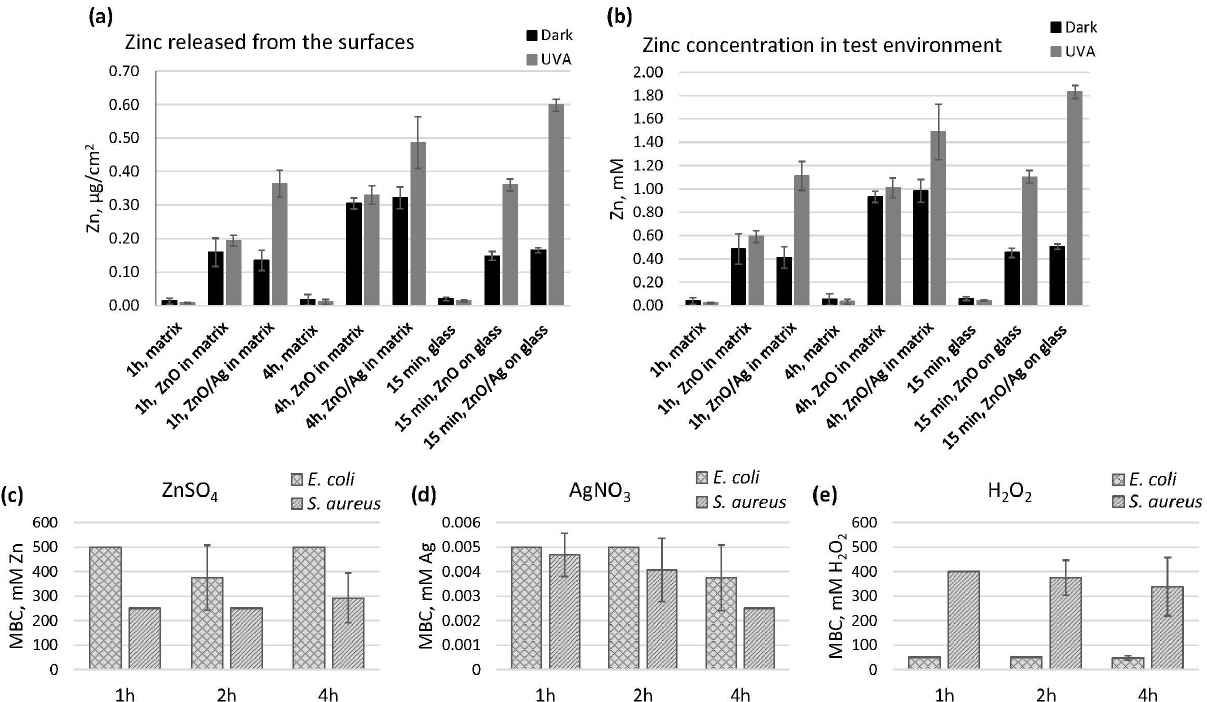
Figure 5. Zinc release from the nano-ZnO- and nano-Zno/Ag-based surfaces and minimal biocidal concentrations (MBC) of agents eliciting same or similar toxic effects to the mechanism of action of the nano-enabled surfaces. Release of Zn ( a ) and the corresponding Zn concentration in the test environment ( b ), as well as MBC values of Zn ( c ), Ag ( d ) and hydrogen peroxide ( e ) in the same test medium, are presented. UVA facilitated higher Zn release from surfaces containing nano-ZnO/Ag than from the ones without Ag. Release of Ag to the test environment was below the quantification limit of AAS and below MBC values ( d ). S. aureus was slightly more sensitive to the toxic effect of ionic Zn and less sensitive to ROS attack caused by peroxide than E. coli . Mean value of 3 experiments and at least 6 data points ± SD is presented.